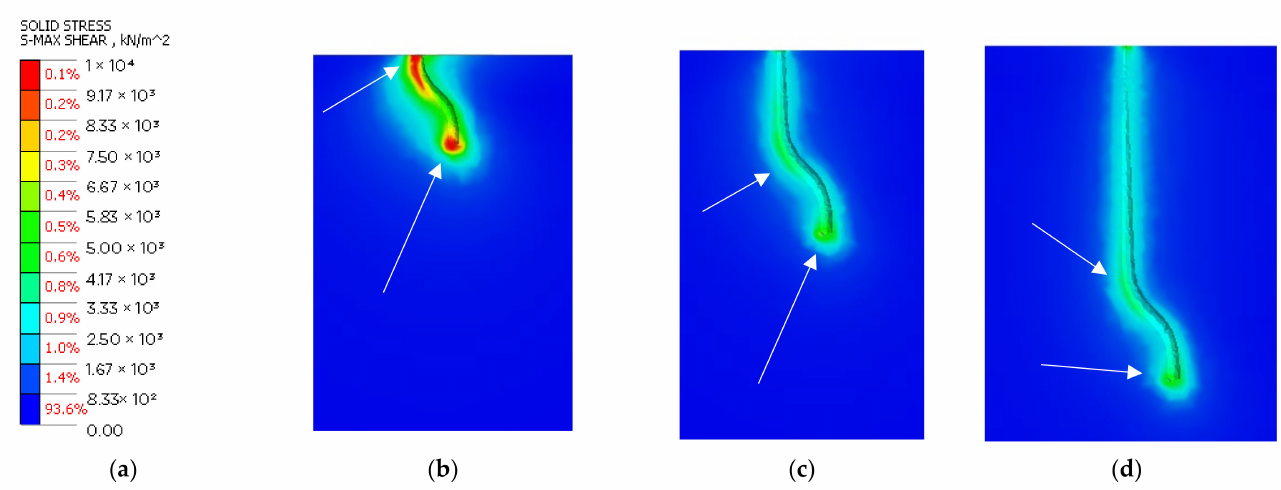
Figure 9. Cross-sectional results of 3D FEA analysis: ( a ) legend; ( b ) 2D cross-section of the model anchored at 10 mm-depth; ( c ) 2D cross-section of the model anchored at 15 mm-depth; ( d ) 2D cross-section of the model anchored at 25